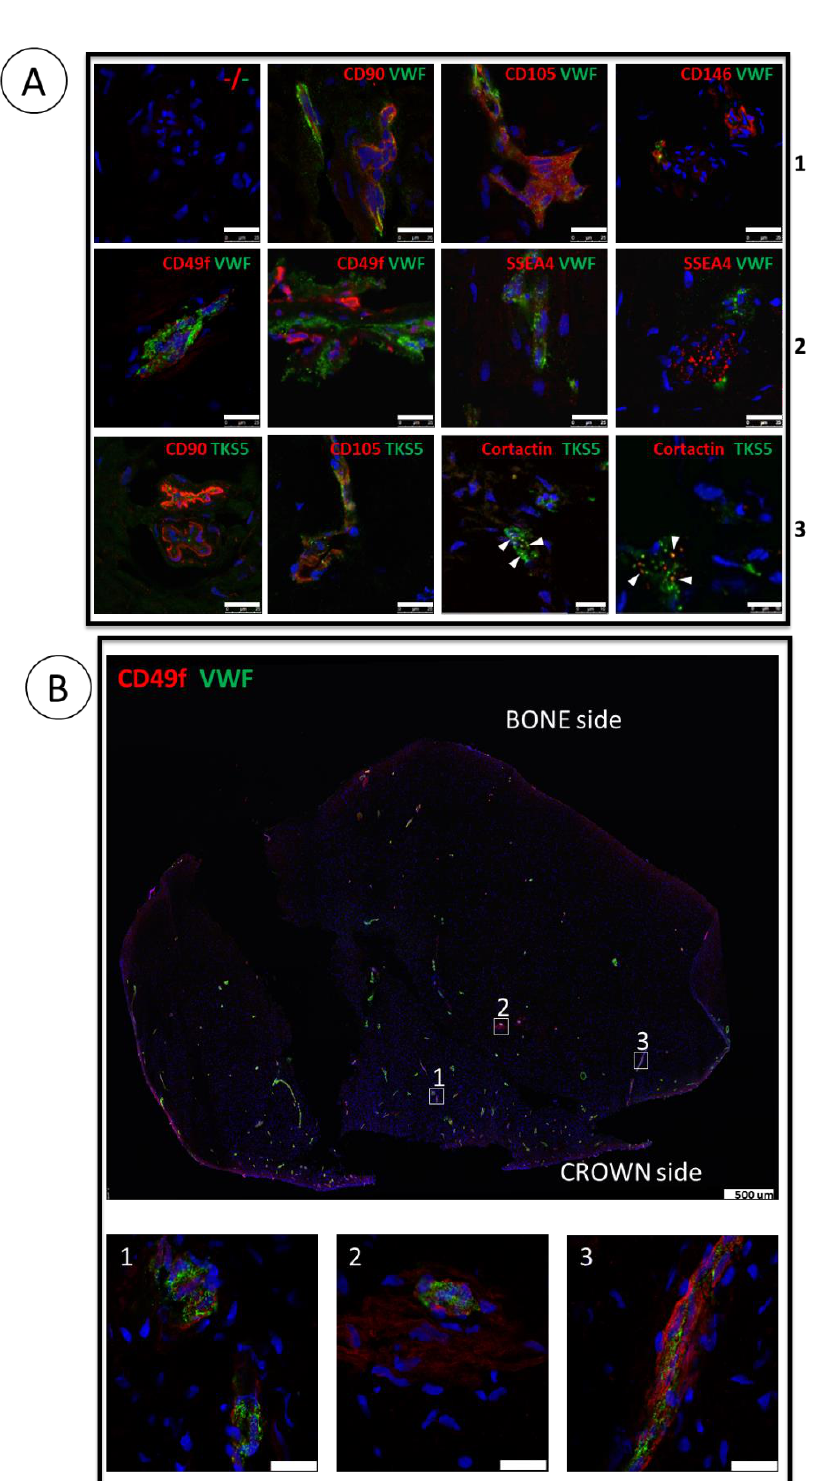
Figure 1. ImmunoMap of the native apical papilla tissue. ( A ) Immunolabelling of 10 µm sections of apical papilla tissue with the indicated antibodies. Nuclei were counterstained with DAPI. Markers analyzed (red/green): 1 : MSC/blood vessels; 2 : Stemness/blood vessels; 3 : Podosome-like structures. Scale bar is 25 µm except for double labelling Cortactin/TKS5: 10 µm. White arrows indicate the colocalization of Tks5 and cortactin, a hallmark of podosome-like structures. ( B ) Immunolabelling of an entire longitudinal section with CD49f and VWF and enlargement of the boxed areas. Scale bar is 500 µm for the entire section and 25 µm in the enlarged images.